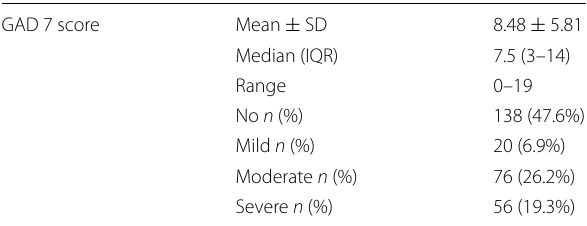
Table 3 Prevalence of anxiety